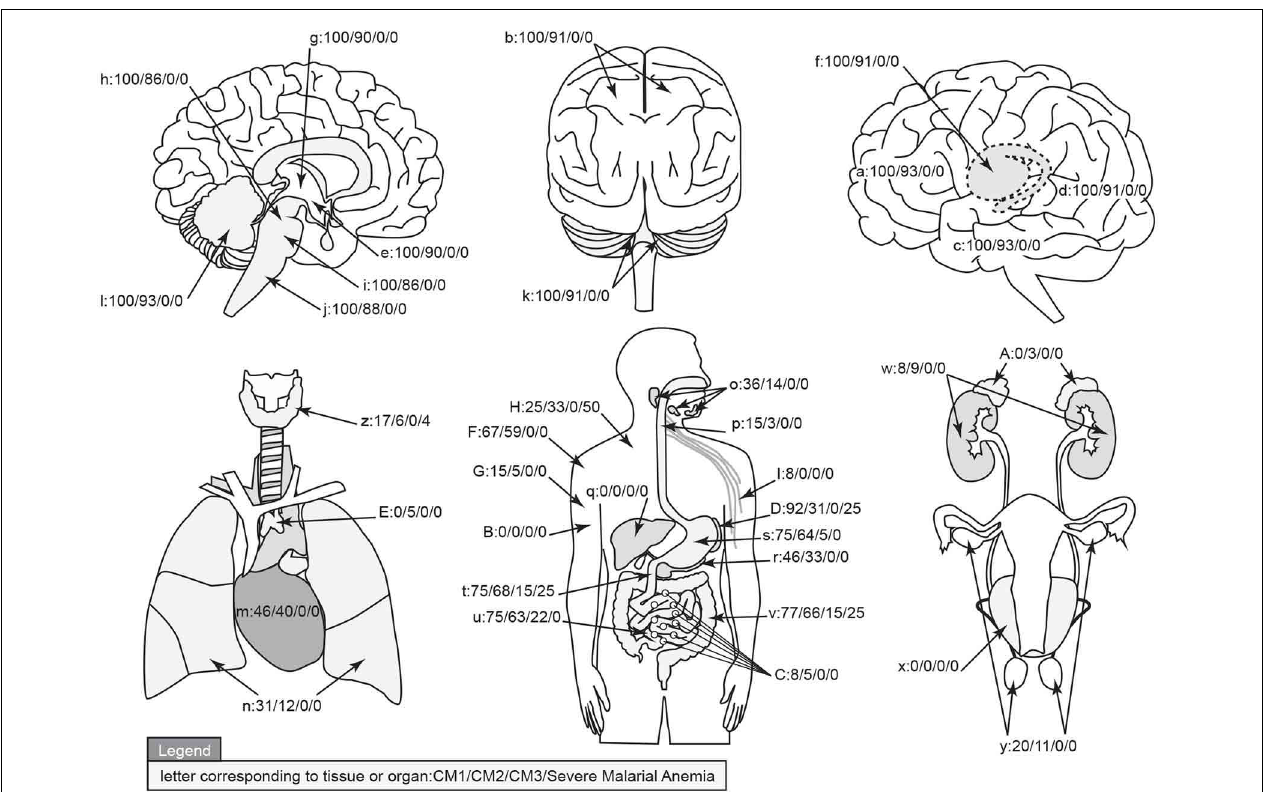
FIGURE 8 | A graphical map of the distribution of parasite sequestration in all organs studied showing the percentages of cases in which sequestration was found for each of the diagnostic categories CM1/CM2/CM3/SMA (where organs were available). For this figure, the definition of “sequestration” was that more than 50% of the red blood cells